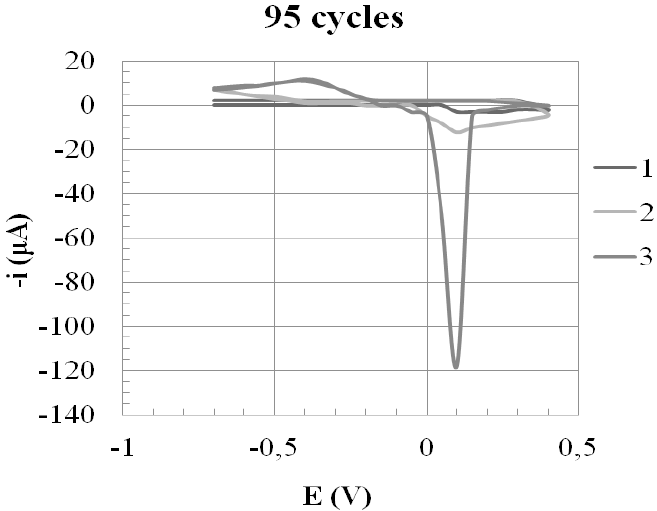
Figure 10. Cyclic voltammograms of (1) 1 mol L -1 H GCE, (3) 1×10 -3 mol L -1 Cu 2+ + 1 mol L -1 H